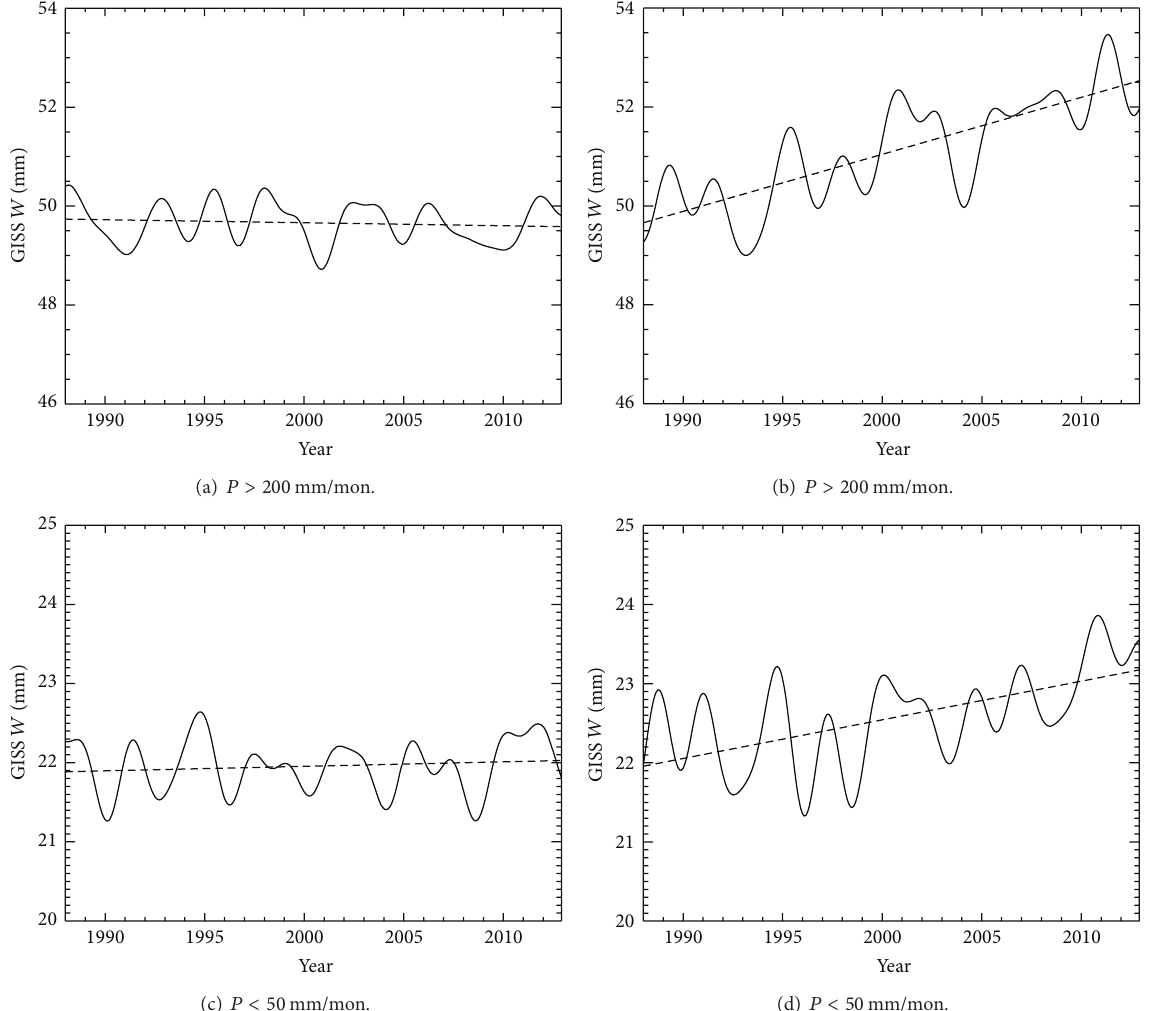
Figure 3: Low-pass filtered time series for column water vapor ( 𝑊 ) from GISS/HYCOM. (a) 𝑊 over high-precipitation area ( 𝑃 > 200 mm/mon.) from the control simulation (solid line) and trend (dashed line). (b) 𝑊 over high-precipitation area from the historic simulation (solid line) and trend (dashed line). (c) Same as (a) except for areas with precipitation < 50 mm/mon. (d) Same as (b) except for areas with precipitation < 50